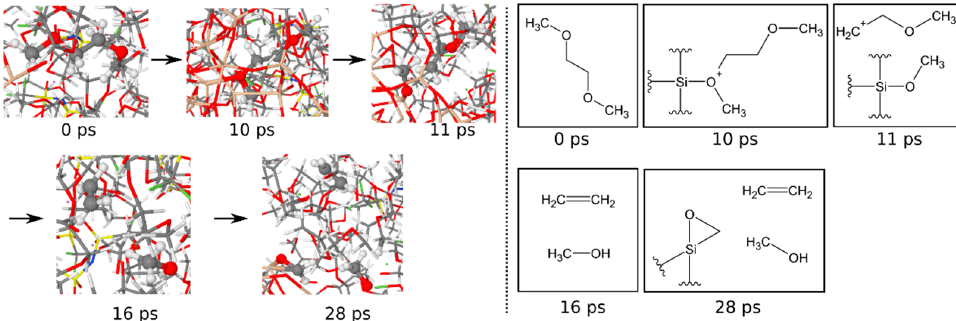
Figure 14. Decomposition of an exemplary chosen DME molecule. Shown are trajectory screenshots as well as the effective Lewis structures of the visible parts.